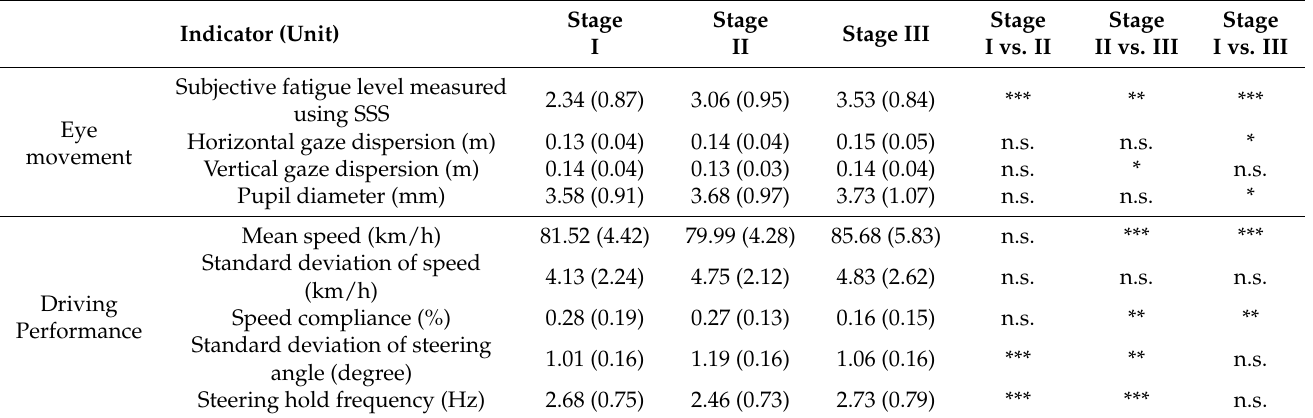
Figure 7. Subjective fatigue level under three stages. (Note: Error bars in this and all following graphs represent standard errors. Two asterisks (**) indicate p < 0.01, and three (***) indicate p < 0.001). Table 4. Overview changes of eye movement and driving performance caused by passive fatigue in different driving stages [ M ( SD